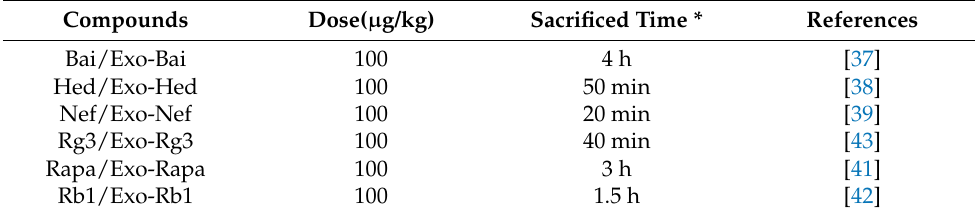
Table 2. Pharmacokinetic studies of the six selected compounds.